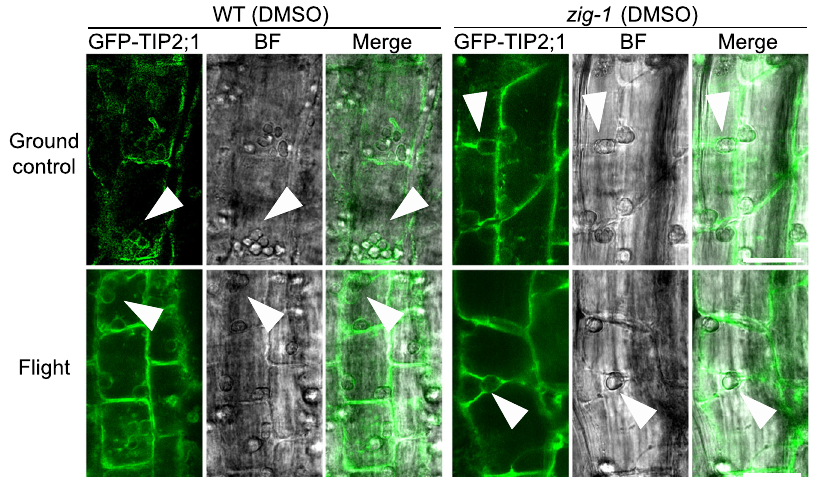
Fig. 5 Visualization of the vacuole and amyloplast inside the hypocotyl endodermal cell. Amyloplasts (where arrows point at) were associated with tonoplast (labeled by GFP) in hypocotyl endodermis of WT and zig-1 in microgravity environment as on earth. Scale bar: 20 μ